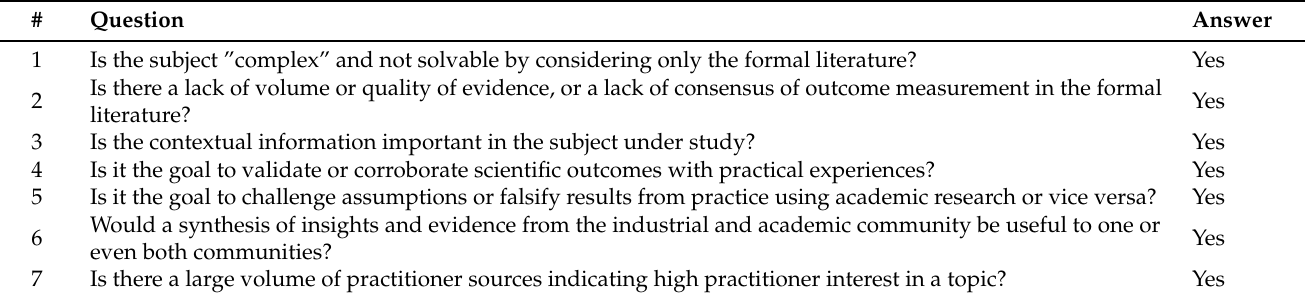
Table 2. Questions asked to decide whether to include the GL in software engineering